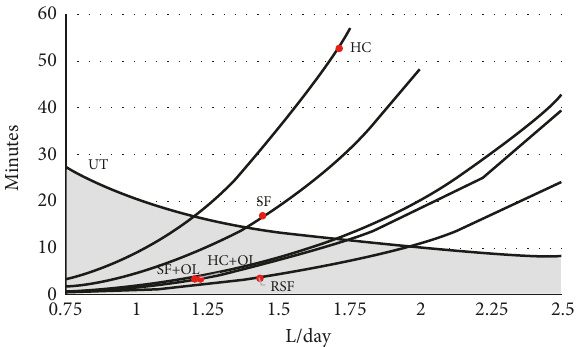
0.75 Figure 5: Induction time of crystallization (IT, minutes) in SF and HC, with dietary Ox load (+OL) and in RSF compared to urinary transit time (UT) through the renal pelvic system (volume 7 mL) at different states of diuresis (L/day): IT at the average diuresis in the group (o), crystallization occurringwithin the kidney (shaded area).